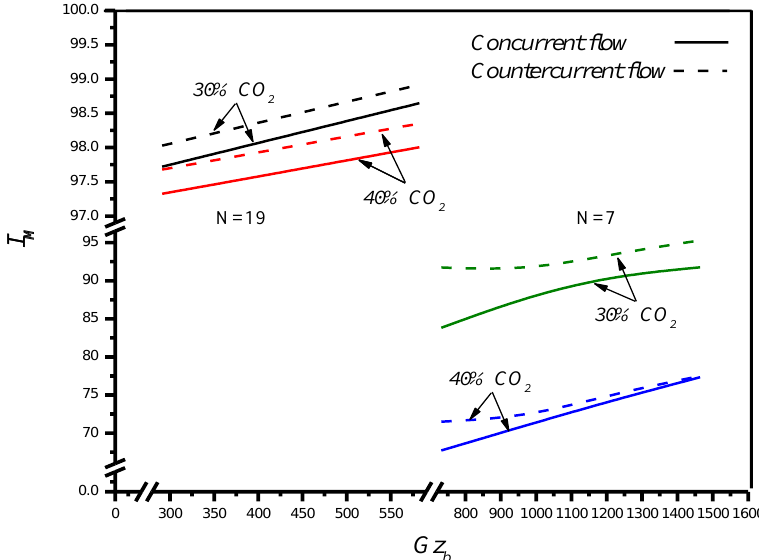
Figure 10. Effects of fiber number, inlet CO 2 concentration, flow pattern and 𝐺𝑧 𝑏 on CO 2 absorption flux ( N = 7 and N = 19).